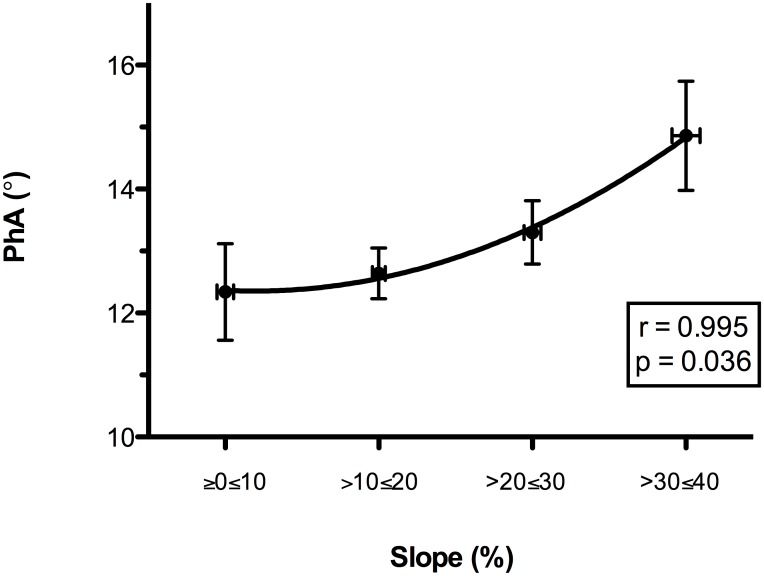
Relationship between ground slope and thoraco-abdominal coordination (PhA) during the run.The ground slope values were grouped into four classes, each associated with a mean PhA value. When the slope increased to over 30%, a significant increase in PhA was observed, representing a decrease in thoraco-abdominal coordination. The best interpolation of these points is represented by the quadratic curve PhA = 12.897–0.773slope + 0.301slope2. Abbreviations: PhA, phase angle.